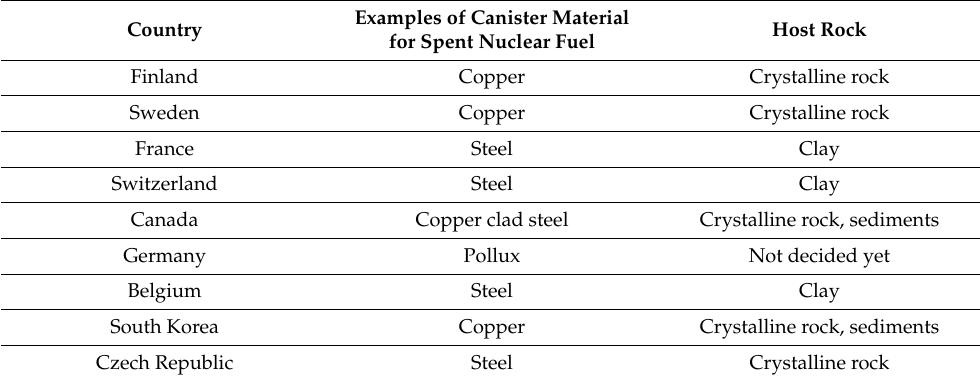
Table 1. Comparison of individual deep storage concepts for SNF and HLW and discussed engineer- ing barriers in selected countries. Examples of Canister Material Host Rock Country for Spent Nuclear Fuel Finland Copper Crystalline rock Sweden Copper Crystalline rock France Steel Clay Switzerland Steel Clay Canada Copper clad steel Crystalline rock, sediments Germany Pollux Not decided yet Belgium Steel Clay South Korea Copper Crystalline rock, sediments Czech Republic Steel Crystalline